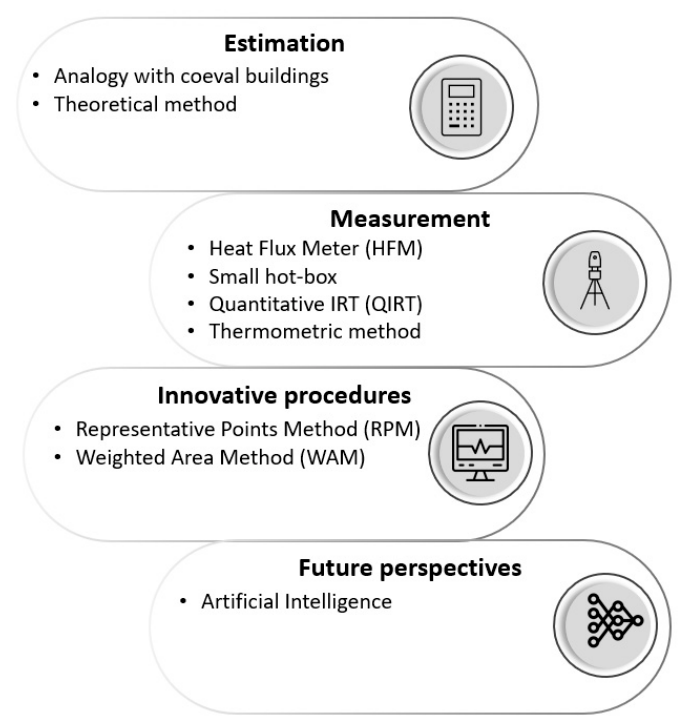
Figure 10. Methodologies for the U-value assessment of the building envelope (source: authors’ elaboration).